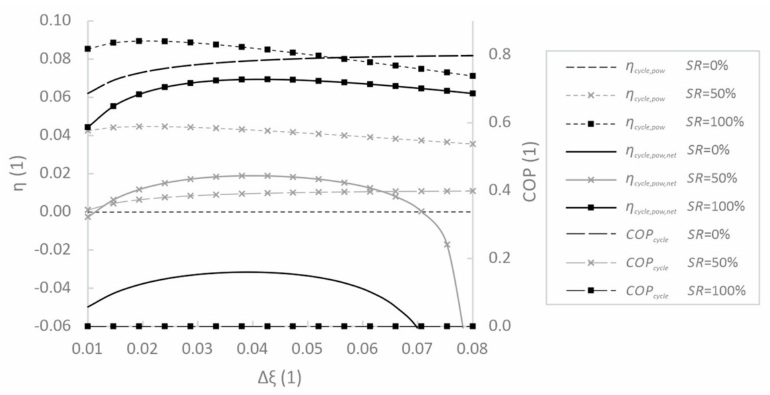
Figure 6. COP and gross and net APCC system efficiencies at varied concentration differences.